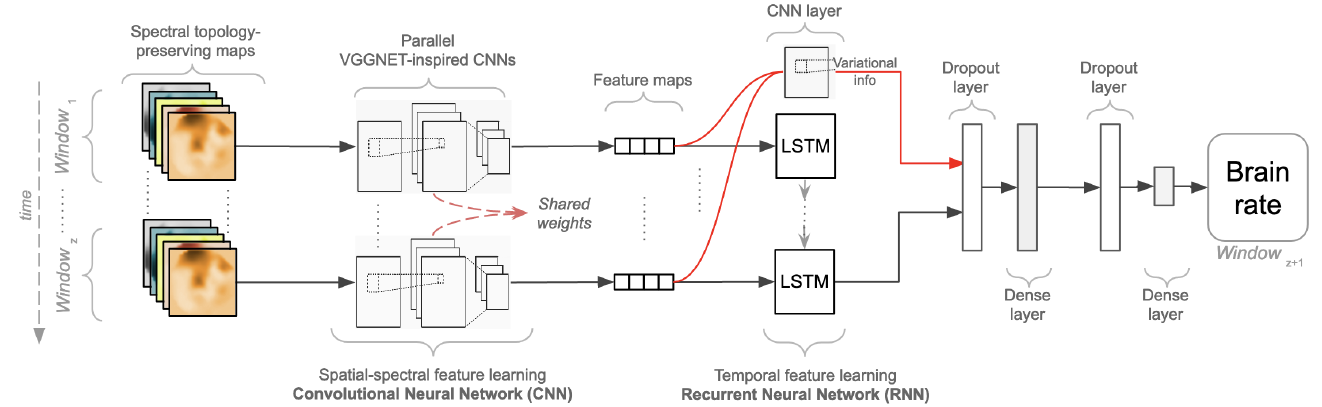
Figure 3. A self-supervised Convolutional-recurrent deep neural network for spatio-temporal learn- ing with spectral topology-preserving head maps and a brain rate. Parallel Convolutional Neural Networks (CNN), inspired by the Visual Geometry Group Neural Network (VGGNET), are injected into a Recurrent Neural Network (RNN) with Long-Short Term Memory (LSTM) layers to learn a brain